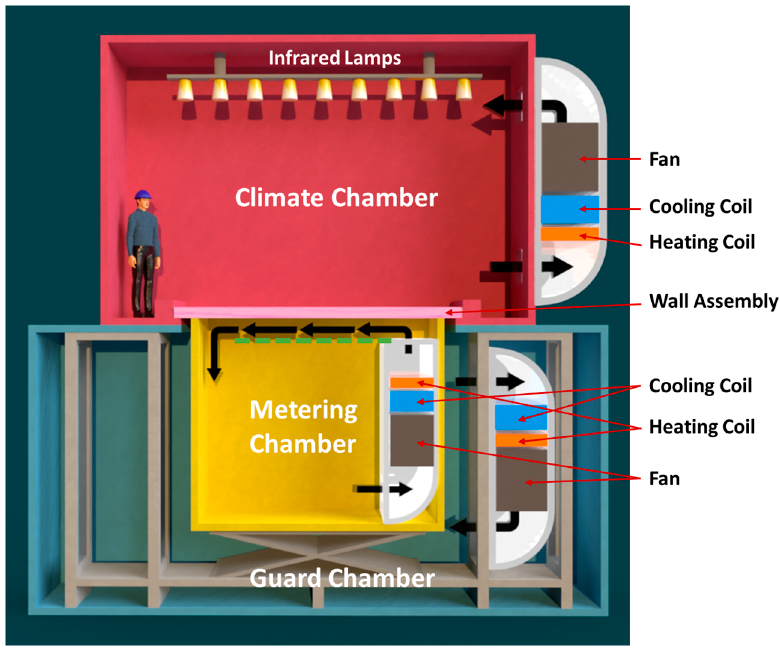
Figure 4. Sketch of the large scale climate simulator (LSCS).